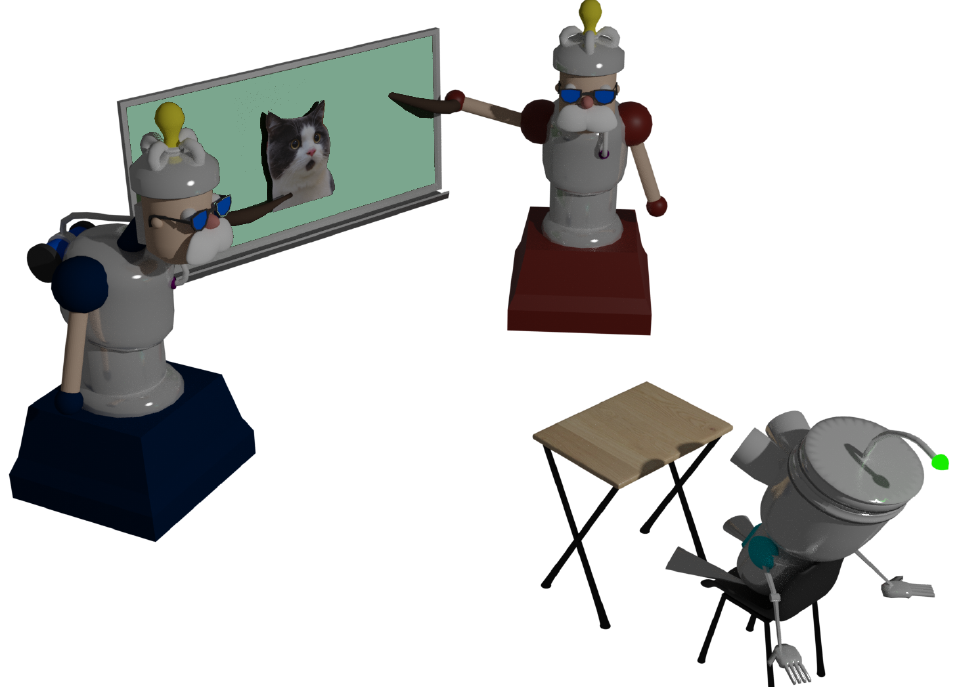
Figure 1. Intuitive representation of the proposed approach: a neural network called student, represented as a small robot, can directly learn from the original data represented on the blackboard and also from the knowledge acquired by more than one teacher. The light on the teachers’ head, unlike the student’s, is not on because their learning is